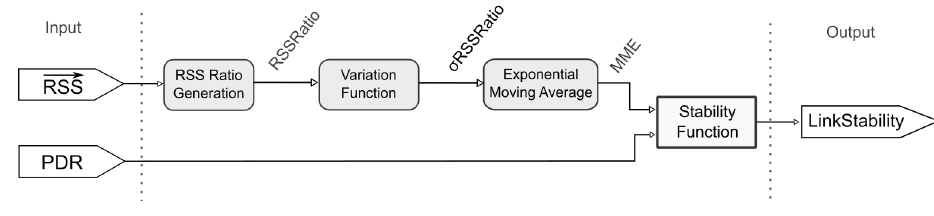
Figure 6. Overview of the method for link stability